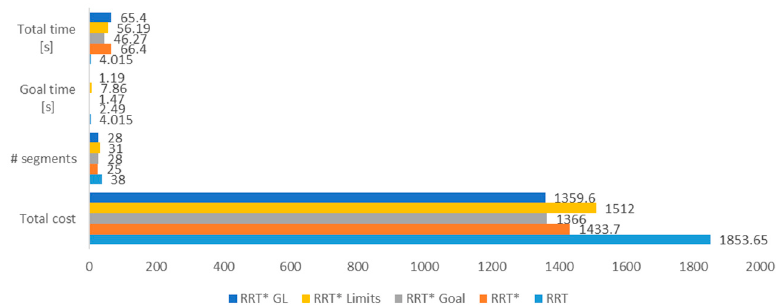
Figure 12. Results of the algorithms for the two obstacles scenario and 600 iterations.